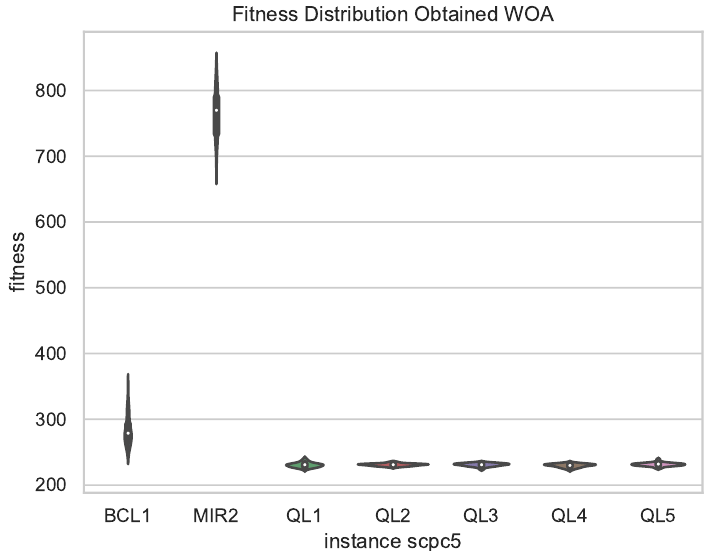
Figure 8. WOA Violin chart of instance c5.